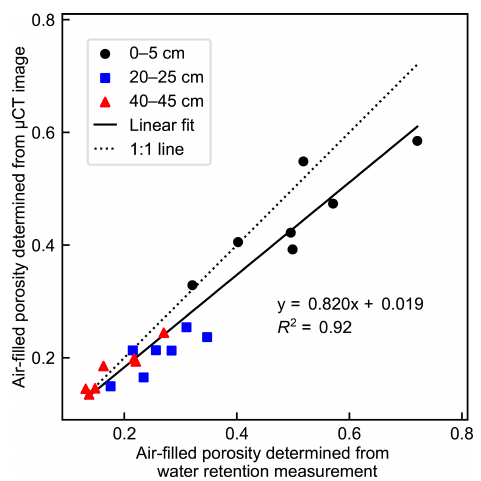
Figure 3. Measurement-derived (determined by subtracting the vol- umetric water content, Eq. 1, from total porosity, Eq. 2) and image- derived (determined as the fraction of void voxels in the binarized µCT image) air-filled porosities of all the cylindrical peat samples from different depths at − 10kPa matric